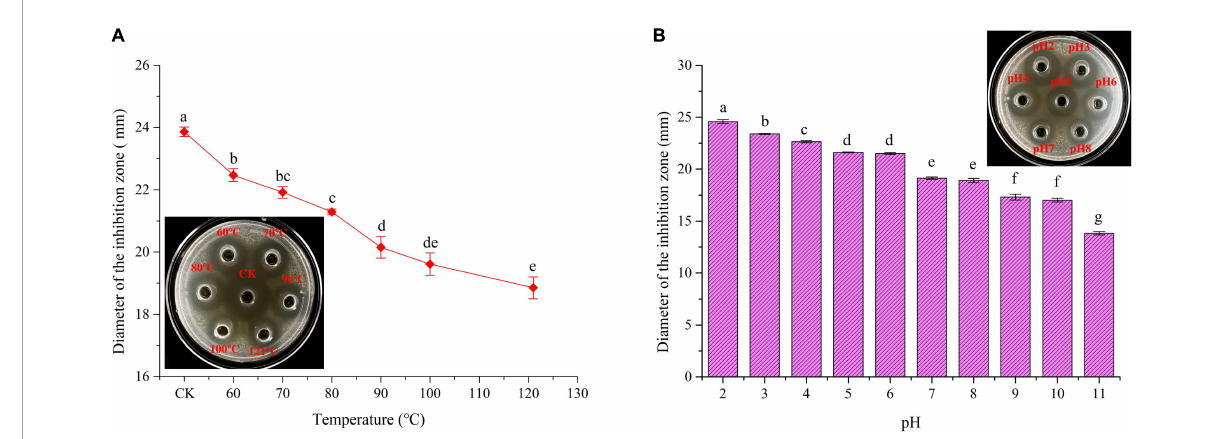
FIGURE5 Thermal and pH stability of plantaricin W3-2. (A) Thermal stability of plantaricin W3-2, inserted: picture was corresponding inhibition zone, CK was the control group. (B) pH stability of plantaricin W3-2. Different letters indicate statistically significant differences between the means ( p <